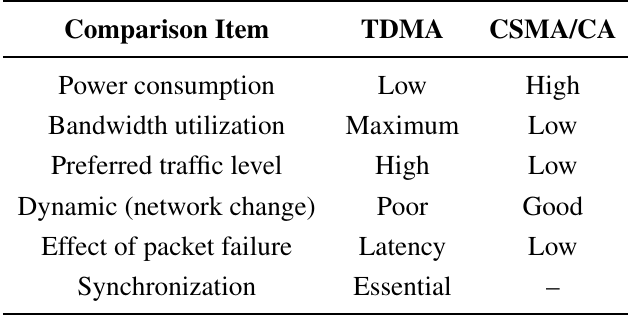
Table 2. Comparison between TDMA and